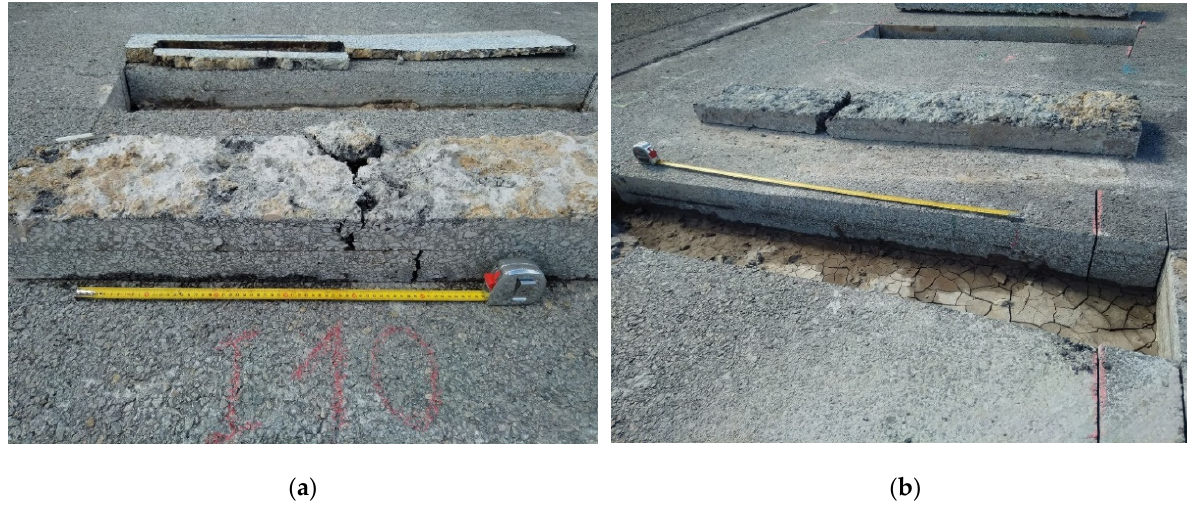
Figure 39. Transverse trenches and corresponding asphalt slabs of ( a ) defect I-10 and ( b ) defects I-12.